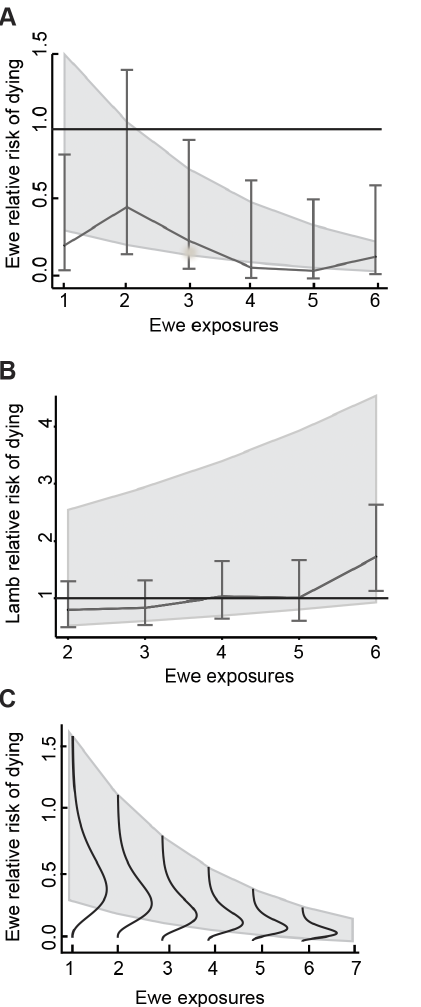
Figure 4. Relationship between cumulative past exposure and risk of dying. a. Ewe risk of dying from pneumonia as a function of the number ( count ) of previous exposures (relative to unexposed ewes). A relative risk of 1 on the y-axis represents no effect of count on the risk of dying of pneumonia. The shaded area represents the 95% confidence bounds on the hazard ratio associated with continuously increasing number of previous exposures (in a model fit on an age-scale that included a fixed effect for translocation status). The error bars bound the 95% confidence range for the uniquely estimated hazard ratios associated with each value of count . The line connects the estimated median risk of dying relative to the risk for previously unexposed ewes. Count values above six are grouped within the count =6 category. b. Lambs’ risk of dying in a pneumonia epidemic given the number of times the lamb’s mother was exposed. The shaded area represents the 95% confidence bounds on the hazard ratio associated with continuously increasing number of previous exposures ( count ) of the ewe (in a model fit on lamb age-scale that included a fixed effect for ewe’s translocation status). The error bars bound the 95% confidence range for the uniquely estimated hazard ratios associated with each number of exposures for ewes. The line connects the estimated median risk of lamb mortality. c. A conceptual diagram illustrating how individual frailty may drive the apparent relationship in part a. Frailties decrease as number of exposures (or age) increase because the weak (at the upper tail of the distribution) die first, and cannot be observed in later years, leaving an increasing proportion of strong individuals.